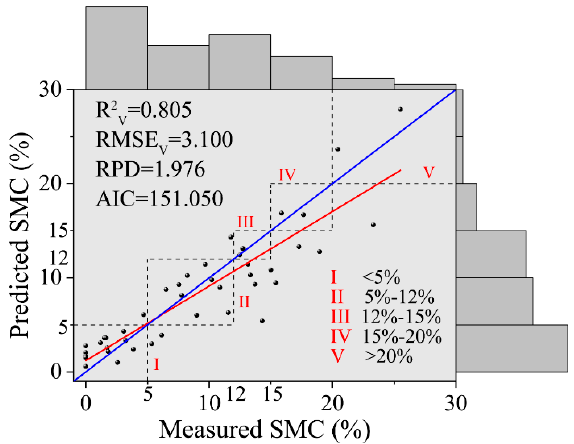
Figure 18. Scatter plot of optimal partial least squares regression (PLSR) model verification.